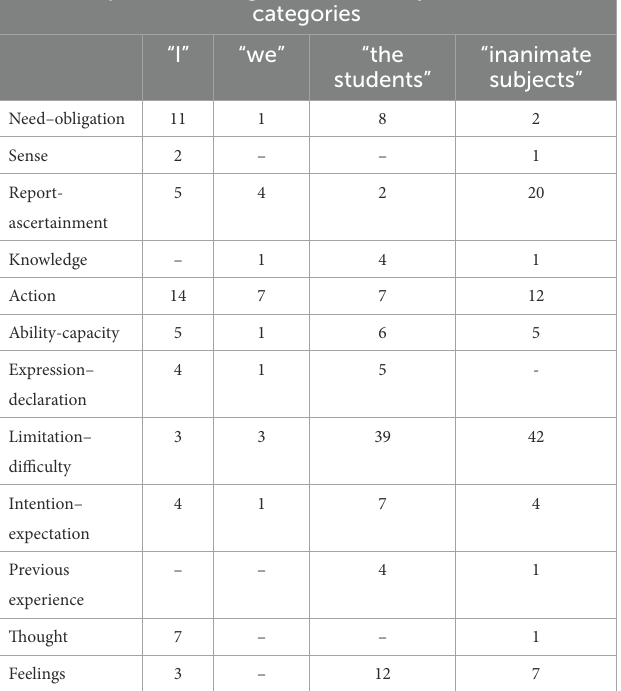
TABLE 4 Correspondence between grammatical subjects: Semantic categories. Correspondence of grammatical subjects: semantic